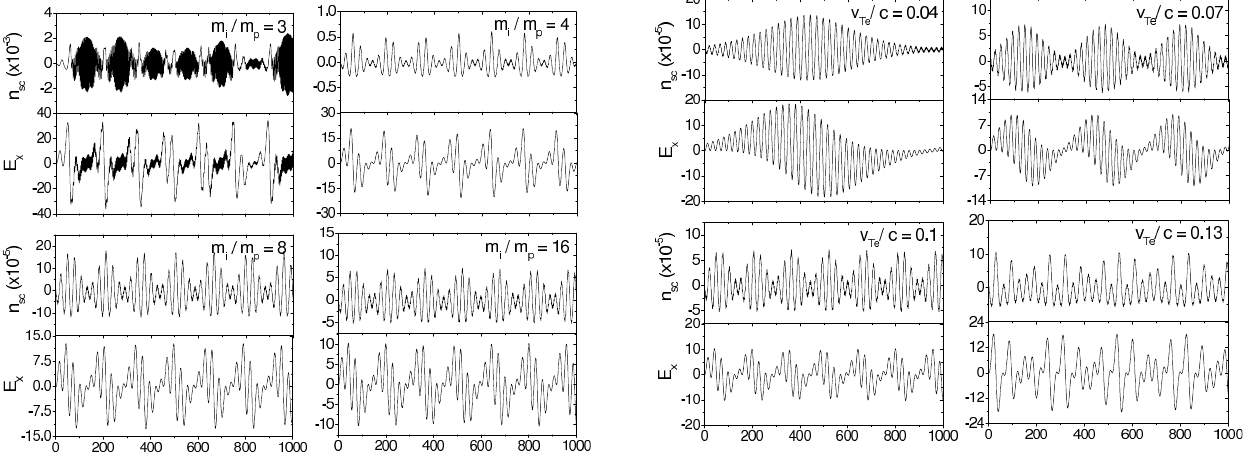
Fig. 14. Same as Fig. 13 but the impact of ξ m = m i /m e on LH- oscilliton waves. Notice that the panels of m i /m e =16 is the typical case discussed in the last section.